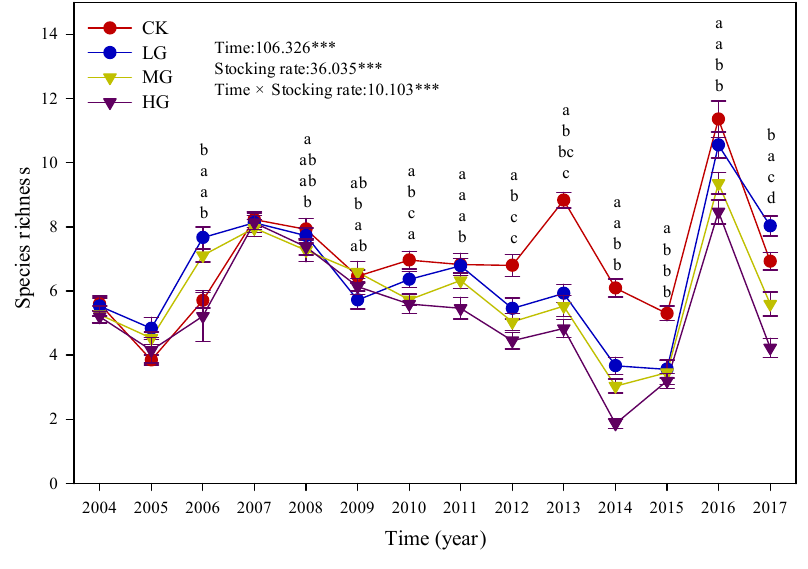
Figure 2 Species richness under four stocking rates from 2004 to 2017. e F value and p values of the effects of time, stocking rate, and their interactions obtained by repeated measures ANOVA were adjusted according to Greenhouse–Geisser’s method as the data failed to pass the Mauchly’s test of sphericity. Different letters in the same column indicate significant differences among treatments, and no letter notes were added when there were no significant differences among treatments. CK – nongrazed; LG – lightly grazed (0.91 sheep unit hm − 2 half year − 1 ); MG – moderately grazed (1.82 sheep unit hm − 2 half year − 1 ); HG – heavily grazed (2.71 sheep unit hm − 2 half year − 1 ).